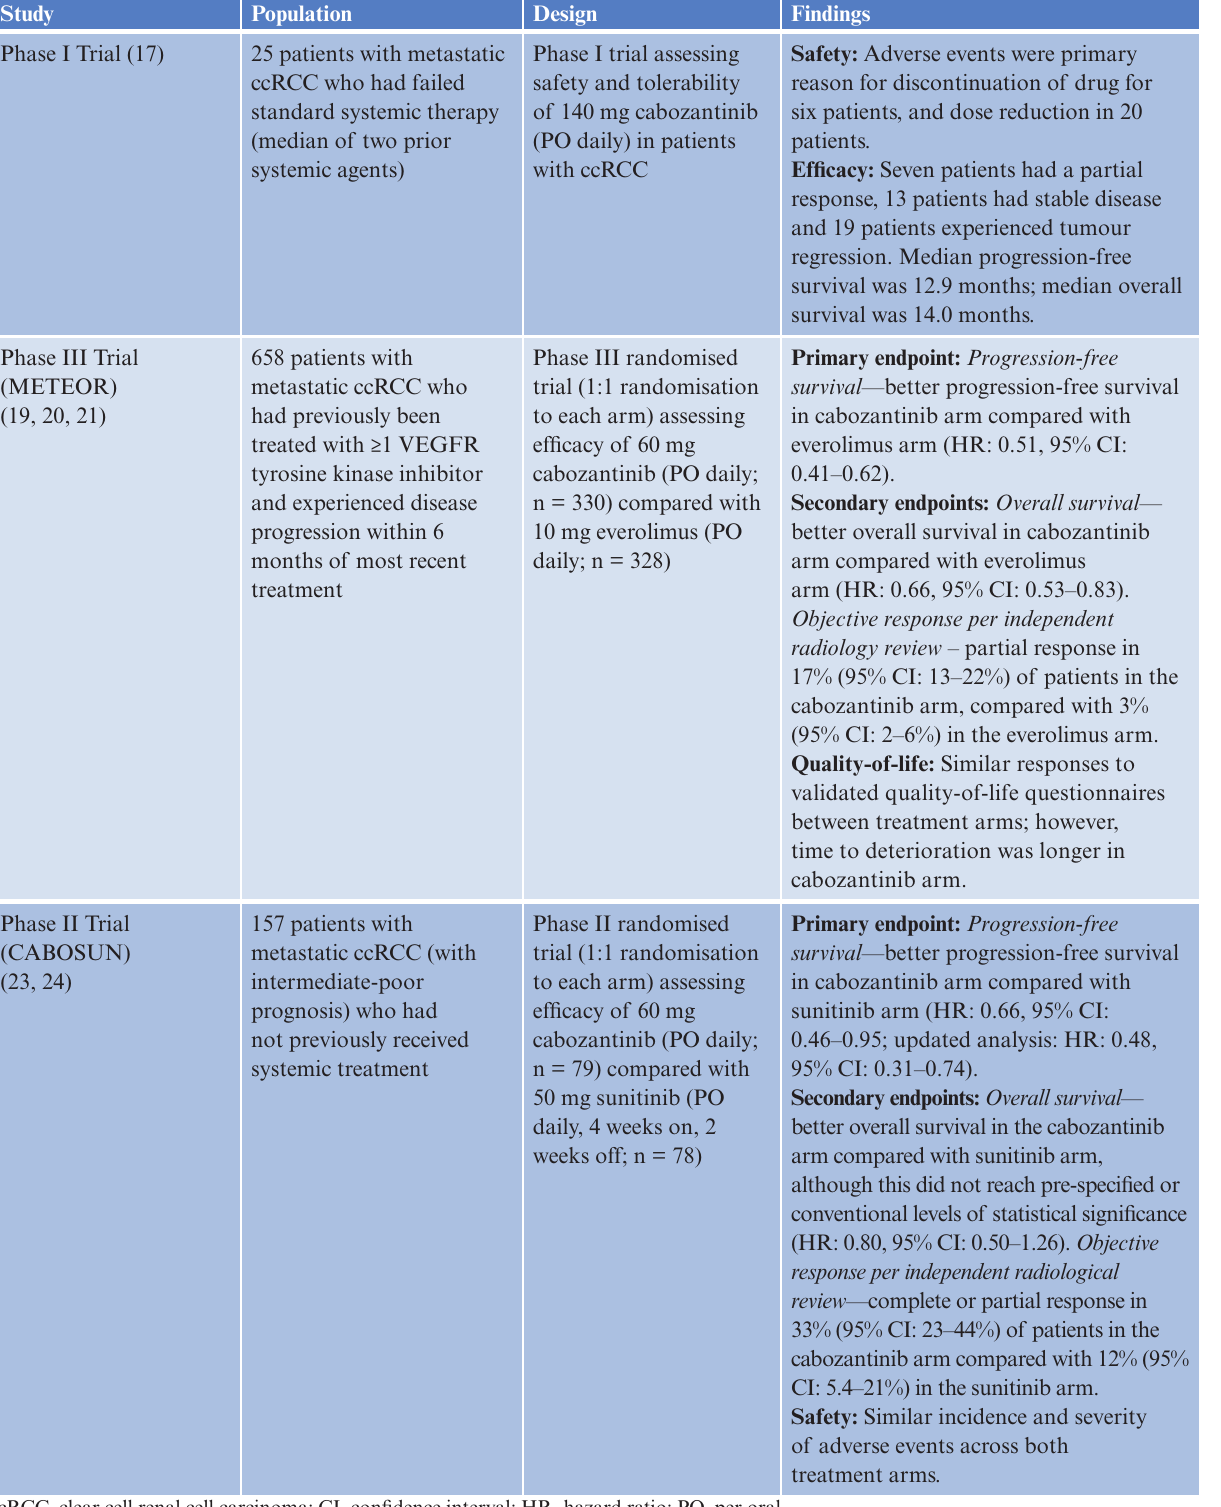
Table 1. Clinical trials of cabozantinib in patients with metastatic ccRCC